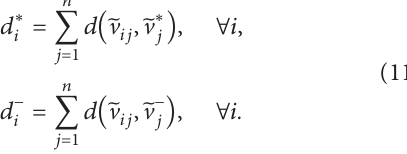
presented in Table 3. These variables are then converted to the corresponding TFNs.